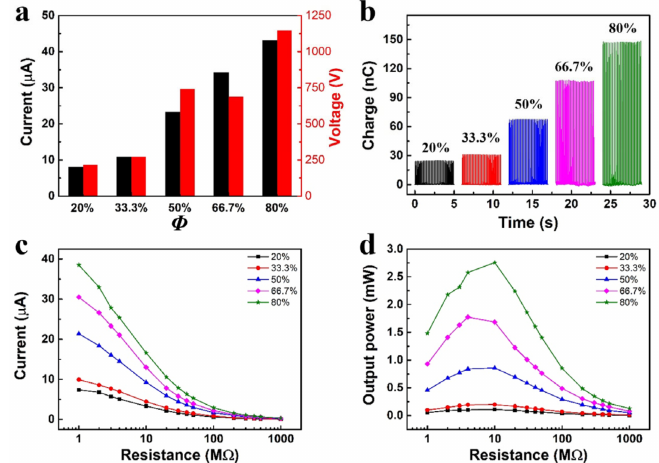
Figure 4. The coating composition as a function of the triboelectric output. ( a ) Bar plot of the short circuit current and open circuit voltage, ( b ) transferred charge. Current ( c ) and output power ( d ) of the TENGs with different Φ under the different load resistance.